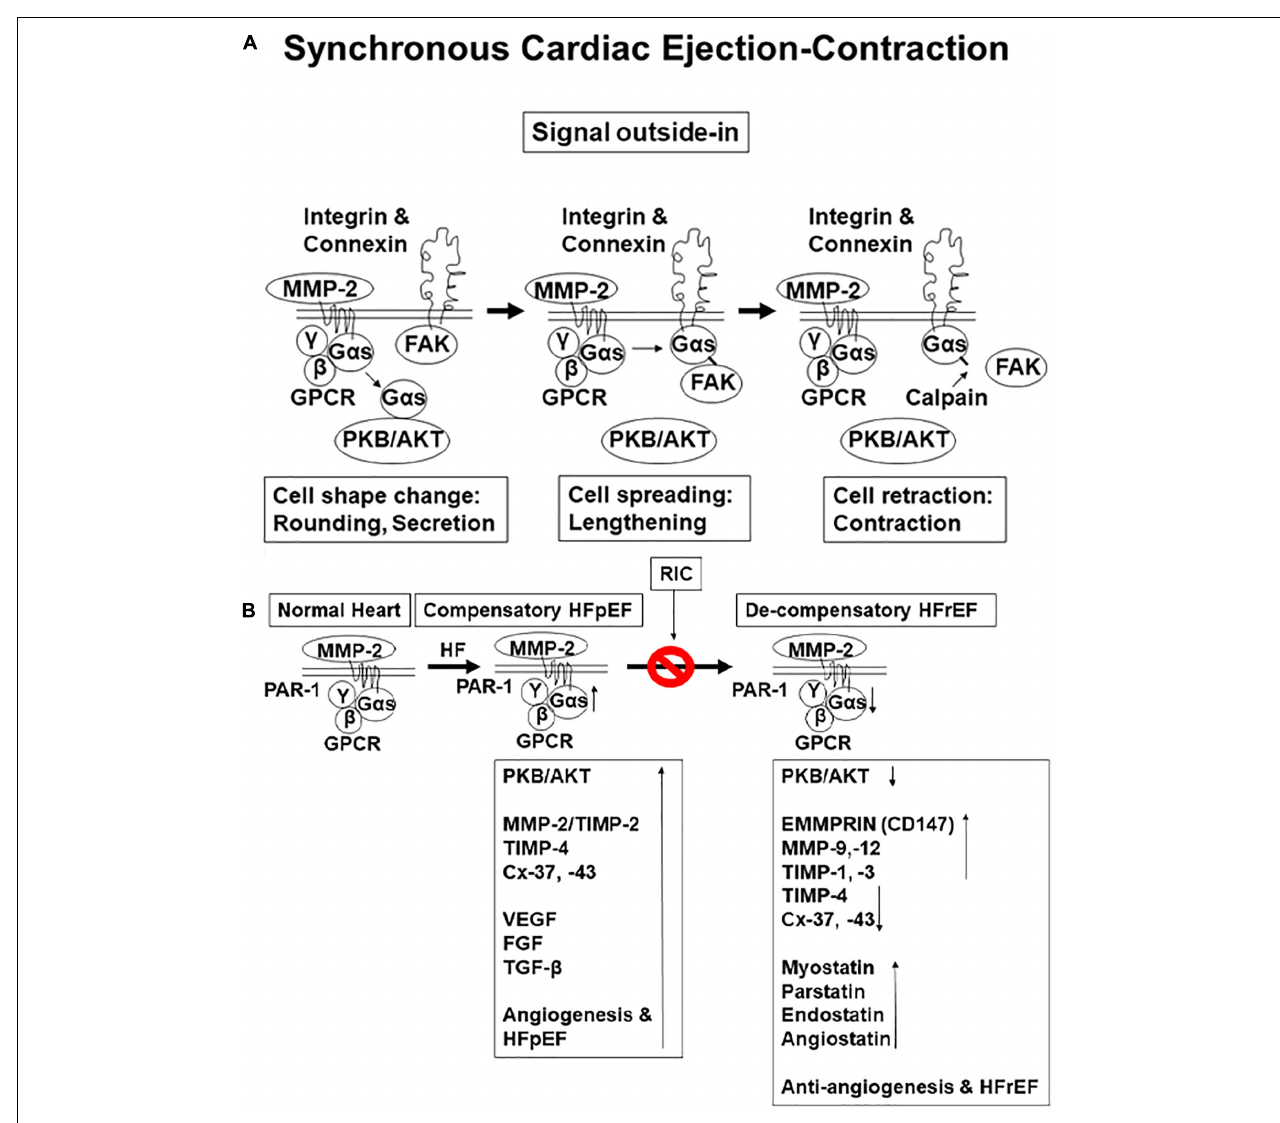
FIGURE 1 | (A) Physiological function of a contractile cell: synthesis, relaxation, and contraction (i.e., cell protein synthesis, spreading, and migration). (B) The hypothesis is that with aging chronic volume overload by preload-induced heart failure (HF) initially is with preserved ejection fraction (HFpEF); however, persistence increases in load lead to HF with reduced ejection fraction. This is caused by the decrease in perfusion and coronary reserve and reduced angiogenesis as compared to preserved ejection fraction